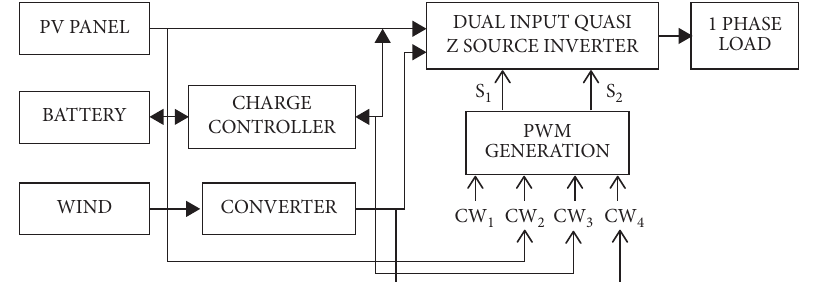
Figure 2: System to evaluate the performance of hybrid qZSI.